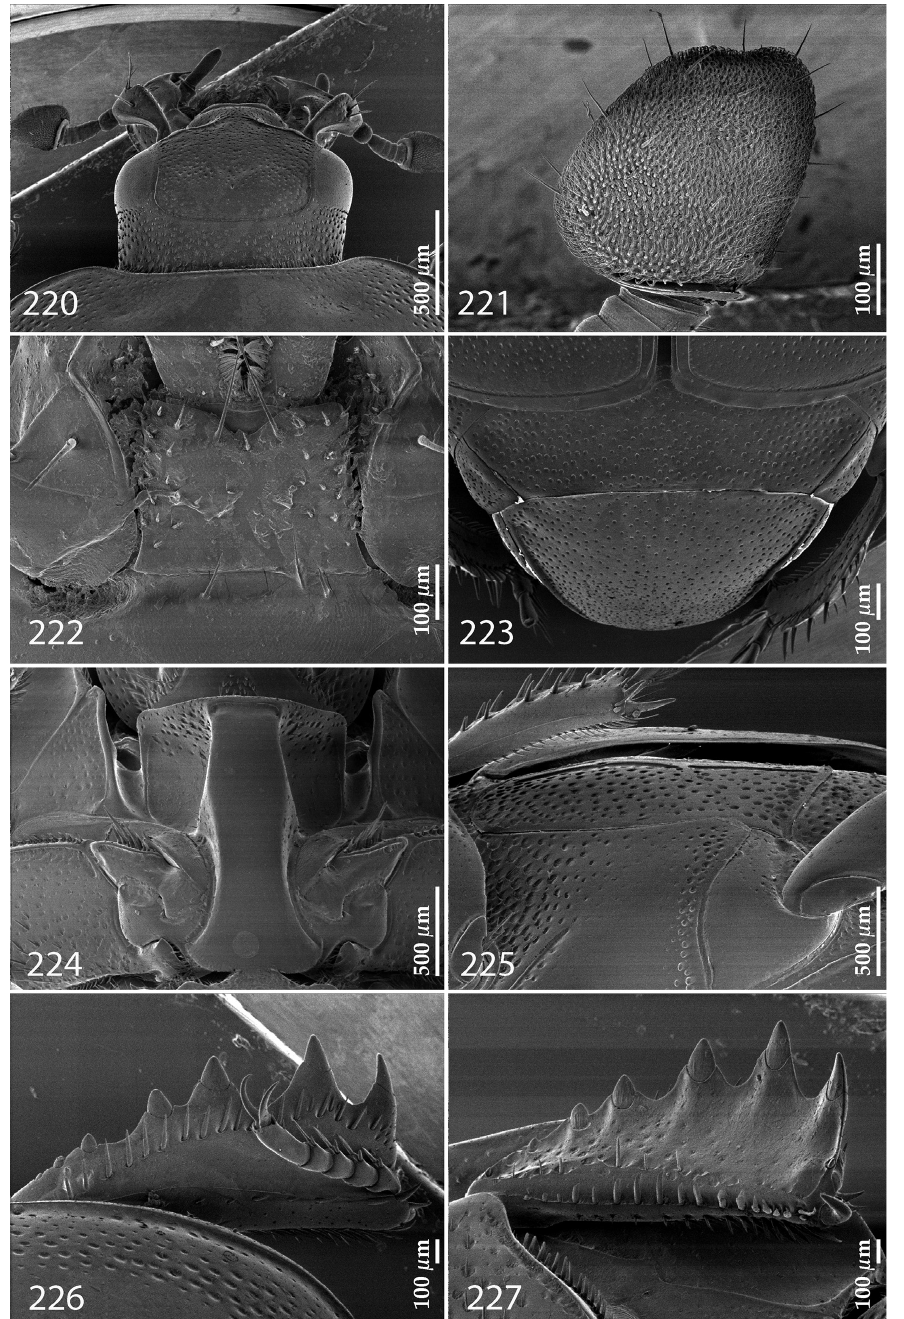
Figures 220–227. 220 Notosaprinus irinus (Marseul, 1862) head, dorsal view 221 antennal club, dor- sal view 222 mentum, ventral view 223 propygidium + pygidium 224 prosternum 225 lateral disc of metaventrite + metepisternum 226 protibia, dorsal view 227 ditto, ventral